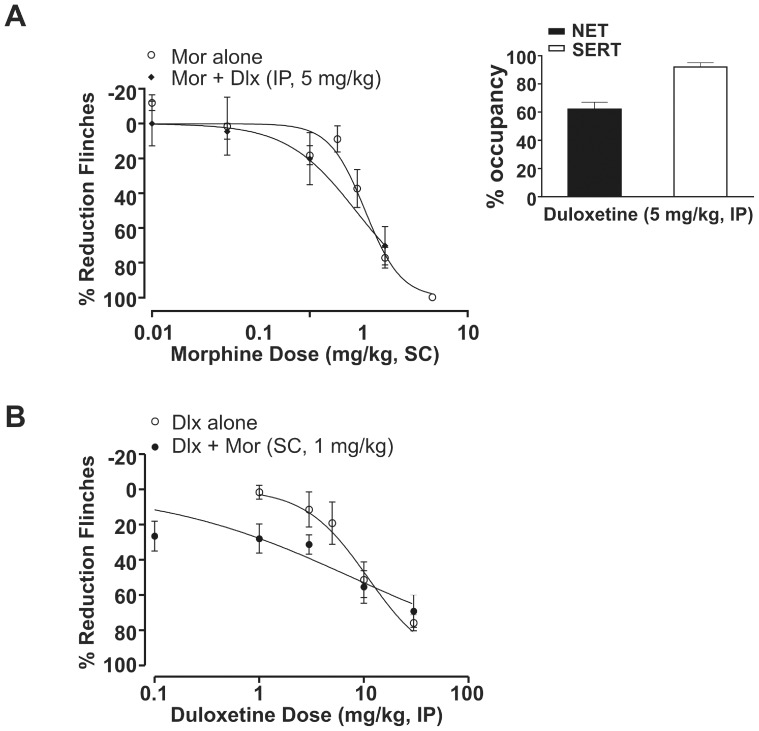
Duloxetine failed to exhibit antinociceptive synergy with morphine in the rat formalin model.(A) Duloxetine (Dlx) at 5 mg/kg failed to shift the morphine (Mor) dose-response curve leftward. Morphine alone: ED50 = 2.3 mg/kg (95% CI: 2.0–2.5); morphine+duloxetine (IP, 5 mg/kg): ED50 = 2.0 mg/kg (95% CI: 1.3–3.0). All data points are shown as mean ± SEM for each group and are expressed as percentage of controls. Inset (A) Duloxetine (IP) at 5 mg/kg was associated with 62±5% for NET and 92±3% for SERT occupancy measured ex vivo at 75 min post-dose. All occupancy data represent mean (± SEM) for each group. (B) A subefficacious dose of morphine 1 mg/kg (SC) failed to left-shift the duloxetine dose-response curve (n = 6–12). Duloxetine alone: ED50 = 10.9 mg/kg (95% CI: 8–15); and duloxetine+morphine (SC, 1 mg/kg): ED50 = 7.7 mg/kg (95% CI: 4–16).